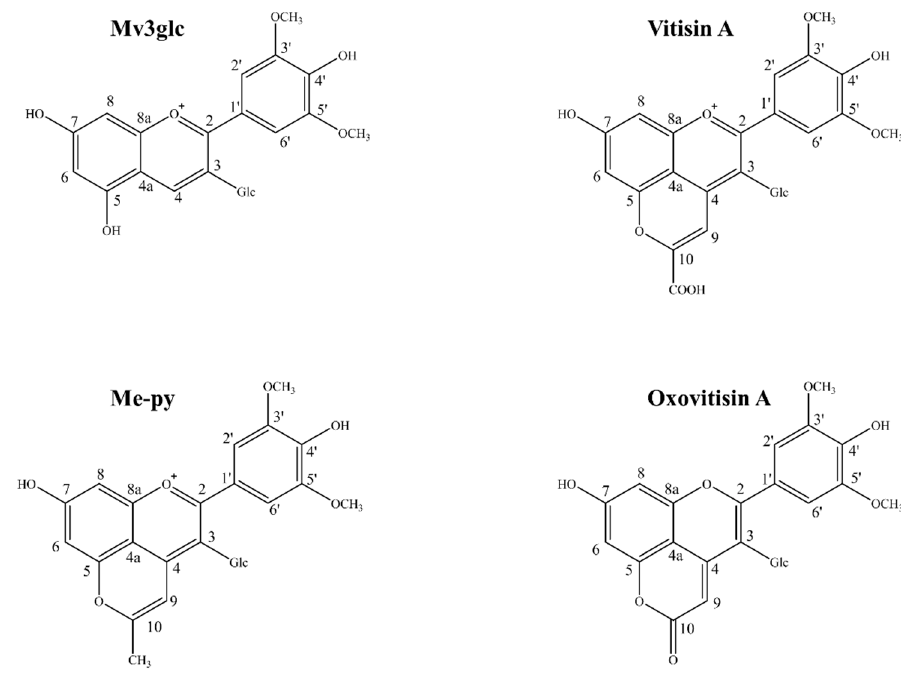
Figure 1. Chemical structures of Mv3glc, vitisin A, Me-py, and oxovitisin A. Anthocyanins have been reported to act in the inhibition of key modulators that promote cancer progression and development [2,15,16]. Publications have demonstrated that anthocyanins have a selective antiproliferation effect on tumor cells while having relatively little or no effect on the growth of normal cells [2]. It has been reported that anthocyanins have an effect on preventing gastric cancer cell proliferation [17,18]. In the stomach, an important digestive organ, 20–25% of anthocyanins are absorbed into the blood circulation in a complete structure within a few minutes after ingestion through a gastric site [19]. The structural influence on their transport efficiency has also been explored by a gastric cell model. Previous research investigated that oxovitisin A had the highest transport efficiency through the gastric cancer cell monolayers in comparison with pyranoanthocyanins and native anthocyanin [20]. Therefore, the antiproliferative effect of oxovitisin A on gastric tumor cells would be interesting with high gastric transport efficiency. After gastric absorption, the remaining anthocyanins are rapidly absorbed and quickly metabolized in the intestine; both intact forms and metabolites, including methylated, glucuronidated, or sulfated derivatives, are appear in the circulation [19]. The effects of anthocyanins on the prevention of intestinal cancer have been widely assayed [21–23], and anthocyanins can inhibit the proliferation of Caco-2 cells by promoting intracellular reactive oxygen species, inducing caspase-3 activation and upregulating the expression of a cyclin-dependent kinase inhibitor [22]. Nevertheless, publications regarding the biological features of pyranonthocyanins with greater stability are lacking, especially oxovitisin A with a similar structure to